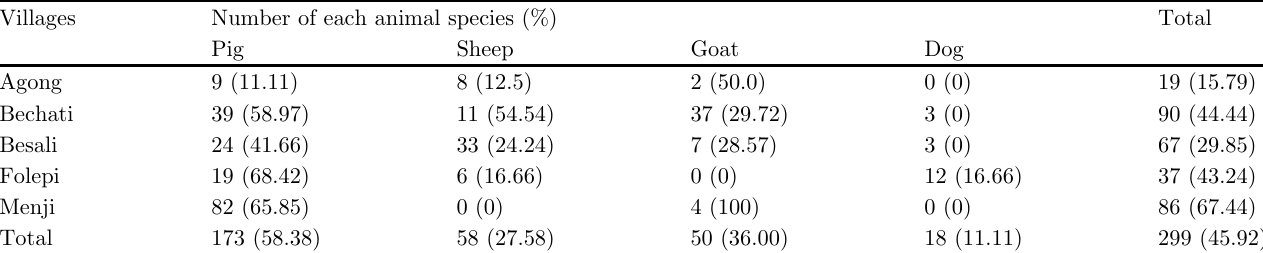
Table 1. Infection rates with T. congolense “ forest type ” according to villages and domestic animal species Villages Number of each animal species (%) Sheep